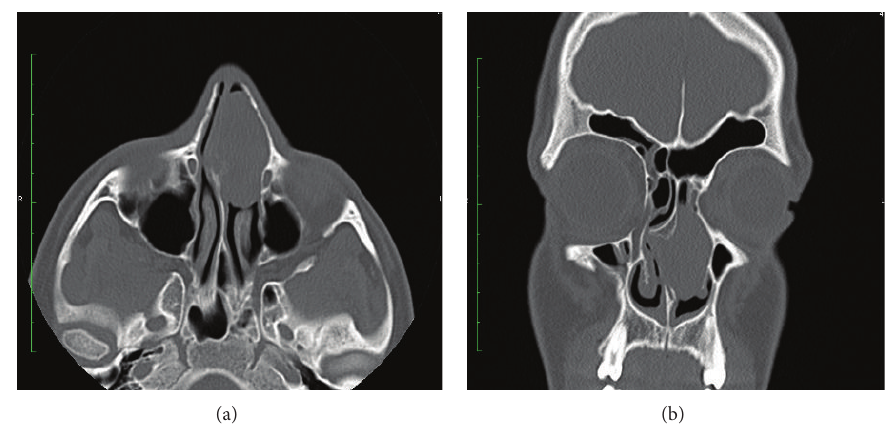
Figure 2: The image of the mass at the left nasal cavity in axial (a) and coronal (b) paranasal CT.